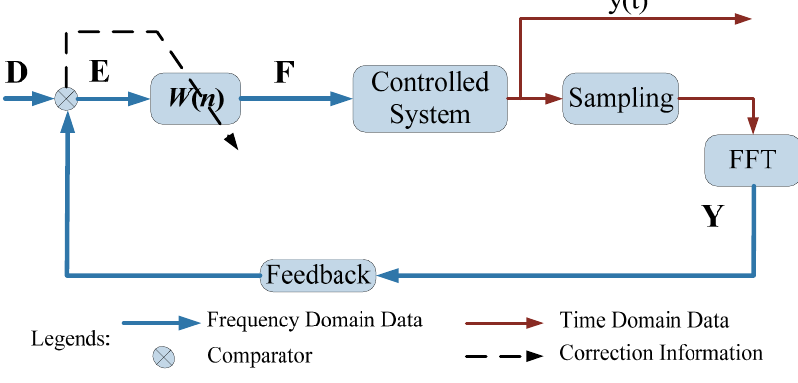
Figure 2. Frequency-domain LMS control scheme.